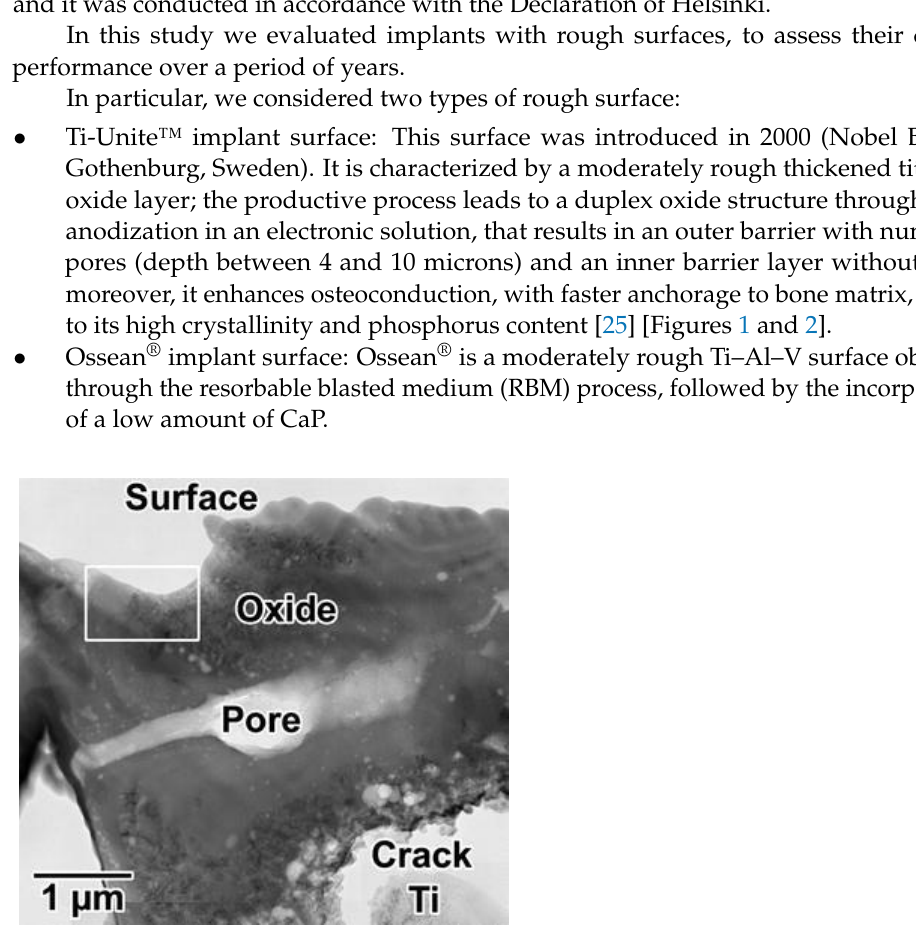
Figure 1. TiUnite™ implant surface: low-magnification transmission electron micrograph. Repro- duced with permission from [26], Copyright Springer,